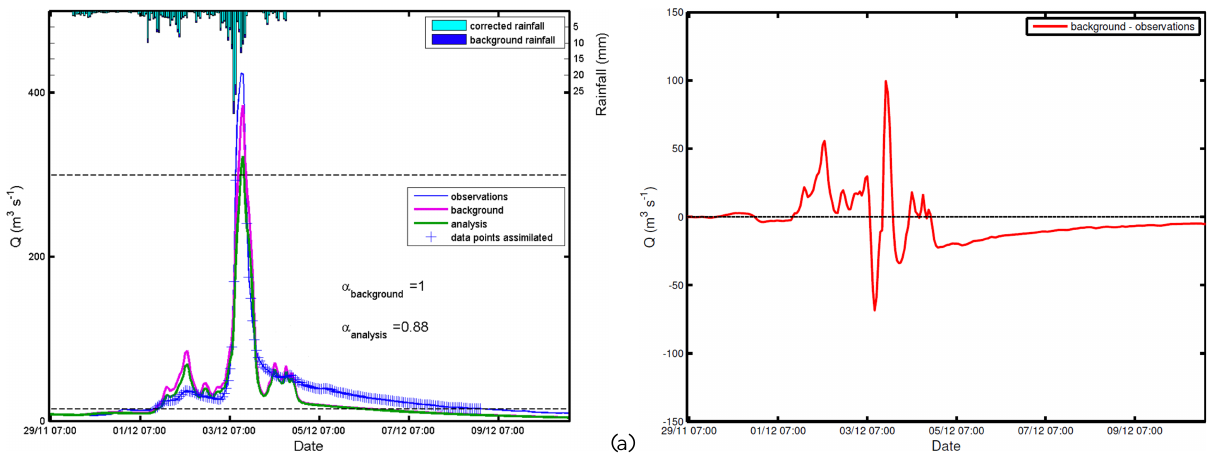
Fig. 12. Reanalysis mode, December 2003: (a) discharges: observations are in blue, the background simulation in pink and the analysis simulation in green; (b) the error in the simulated discharge, Q background − Q observations (red).